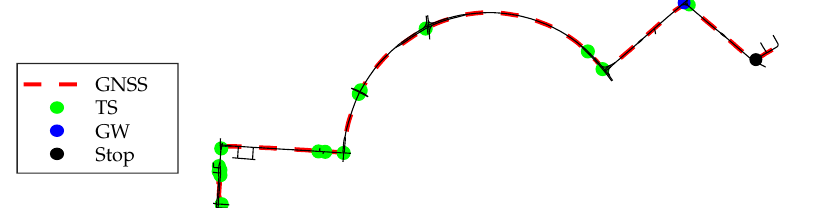
Figure 8. Visualisation of identified OSM Data including GNSS track, traffic signal (TS), give way (GW), and stop.